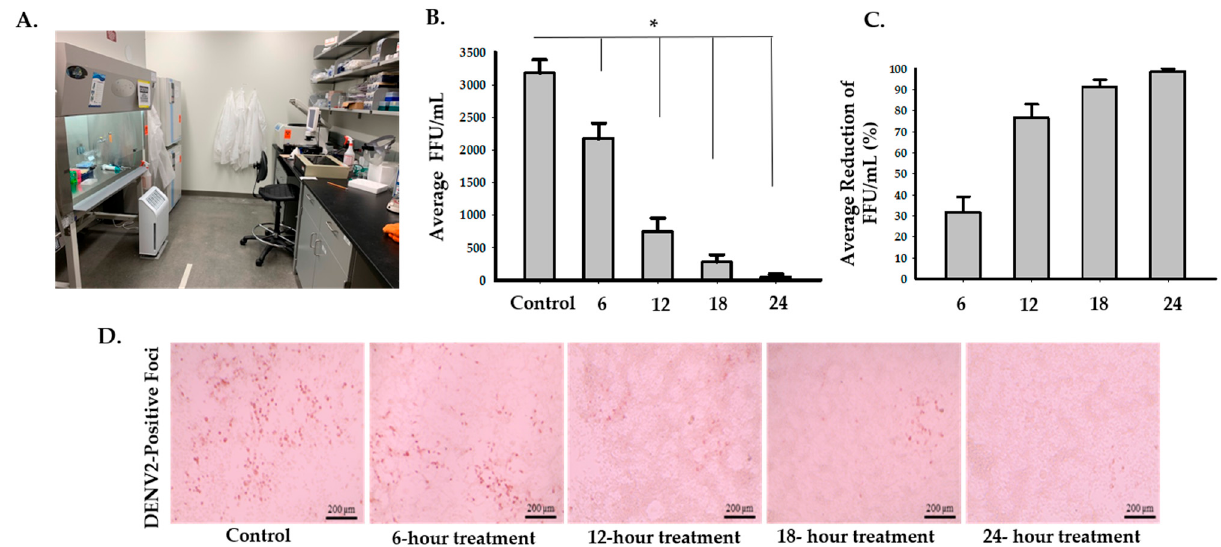
Figure 4. Inactivation of DENV2 with the photocatalytic reactor outside the biosafety cabinet at 6, 12, 18, and 24-h timepoints. ( A ) Image of the photocatalytic reactor placed on the ground next to a biosafety cabinet. Four 96-well plates (three samples in each one) in total were placed inside the biosafety cabinet in the testing room. The fifth 96-well plate containing three samples was placed in the control room. Plates in the biosafety cabinet were removed and placed along with the fifth plate 6, 12, 18, and 24 h post-treatment. ( B ) DENV2 viral growth after exposure to the photocatalytic reactor treatment for 6, 12, 18, and 24 h compared to the control. Multiple Student’s t -test analyses of each treatment and control groups showed that there were significant reductions (* p < 0.05) in infectivity of DENV2 in the treated samples ( p = 0.0326 (M = 2173, SD = 412), p = 0.001 (M = 747, SD = 356), p = 0.0002 (M = 280, SD = 191), and p = 0.0001 (M = 47, SD = 81) after 6, 12, 18, and 24 h, respectively) compared to the control (M = 3180, SD = 354). ( C ) A representative graph for average percentages of reduction in infectivity which were 31.7% (95% CI: 17 to 46.4%), 76.5% (95% CI: 63.8 to 89.2%), 91.2% (95% CI: 84.4 to 98%), and 98.5% (95% CI: 95.7 to 100%) after 6, 12, 18, and 24 h of treatment, respectively. ( D ) Representative digital images of DENV2-positive foci from the control and treated samples were taken at 20× magnification using an Evos Core inverted microscope.